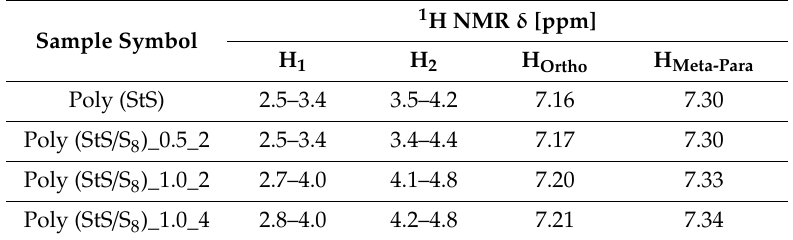
Table 3. The 13 C NMR chemical shifts in poly (StS) and StS / S 8 copolymers.